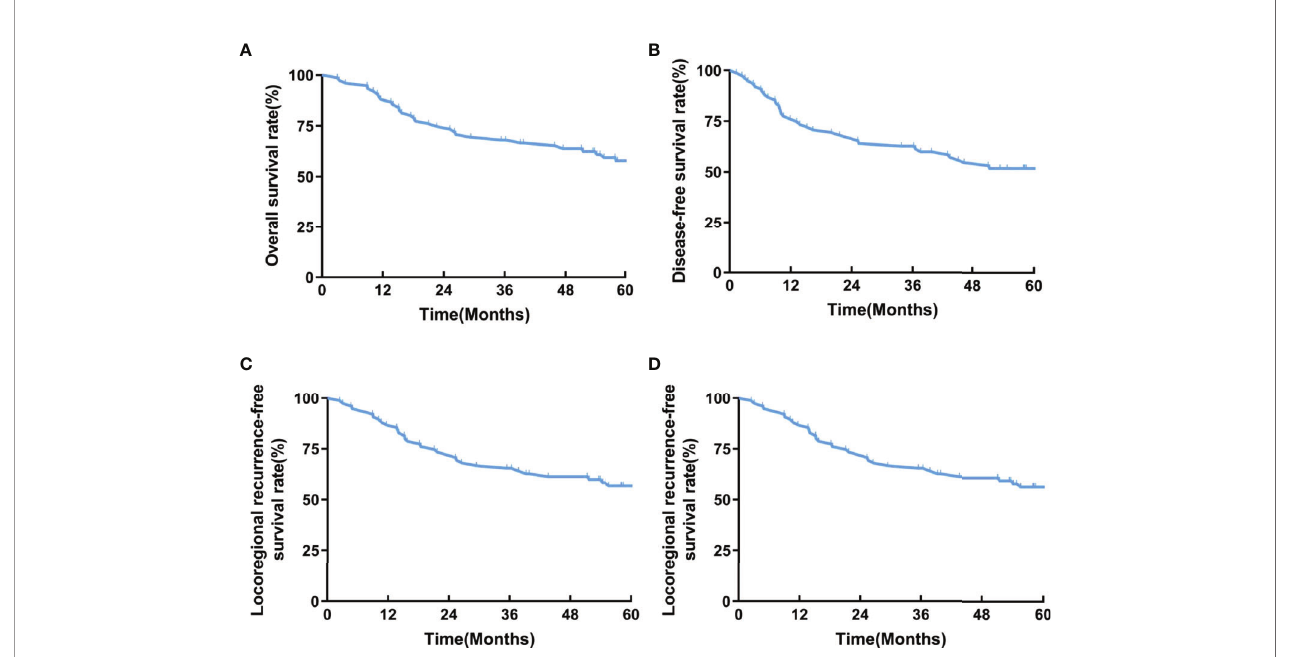
FIGURE 2 | (A) OS, (B) DFS, (C) LRFS, (D) DMFS of the enrolled